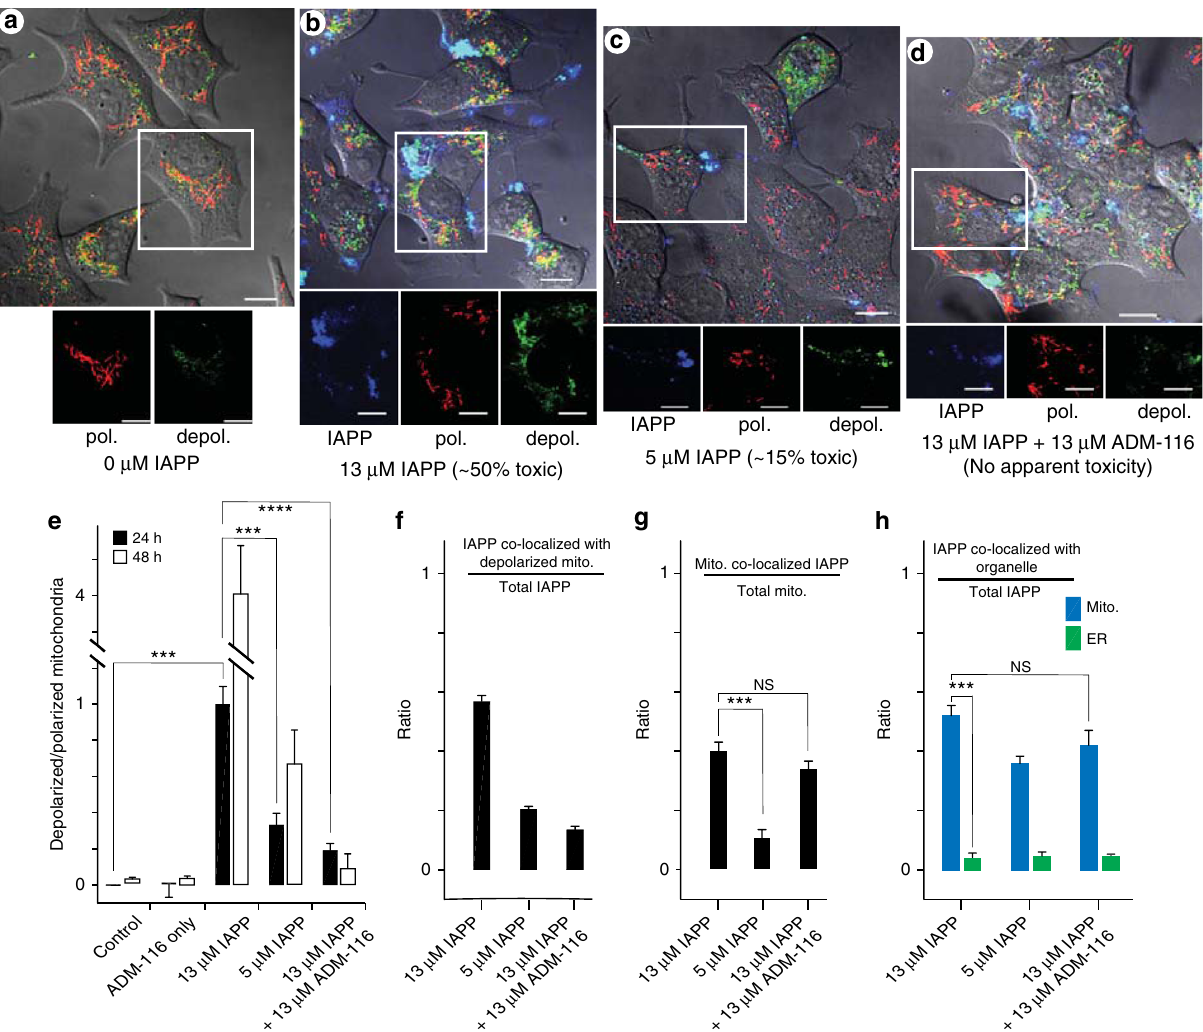
Fig. 4 Mitochondria co-localised IAPP is associated with depolarisation. a Representative INS-1 cells stained with JC-1 marker. Two fl uorescence channels in red and green correspond to polarised and depolarised mitochondria, respectively. These are shown and merged with the differential interference contrast (DIC) image. A region of interest (ROI) is chosen to show channels individually. b Representative cells exposed to toxic (13 μ M) concentrations of IAPP doped with 200 nM IAPP A647 for imaging. Cells were stained with JC-1 marker 24 h after IAPP. The three channels, IAPP A647 (blue), polarised (red) and depolarised (green) mitochrondria are shown merged with the DIC image. A ROI is chosen to show channels individually. c As in b but at 5 μ M IAPP. d As in b , but with the addition of 13 μ M ADM-116 three hours after addition of IAPP (to ensure IAPP is intracellular 16 ). e Image overlap statistics for a – d showing ratio of depolarised/polarised mitochondria at the indicated conditions and incubation time. f Image overlap statistics for a – d showing fraction of total IAPP overlapping depolarised mitochondria. g Image overlap statistics for a – d showing fraction of total mitochondria co-localised with IAPP. h Image statistics showing fraction of total IAPP overlapping with mitochondria and ER. Representative images for these statistics are shown for mitochondria ( b – d ) and ER (Supplementary Fig. 6), respectively. e – h For each measurement, a total of 50 cells from three biological replicates were selected for analysis. Error bars are standard deviations. Statistical signi fi cance of the data was calculated (Student ’ s T -test). Comparisons made in the main text are indicated here with lines and are annotated as *** P < 0.001 and **** P < 0.0001. P -values >0.01 are regarded as not signi fi cant